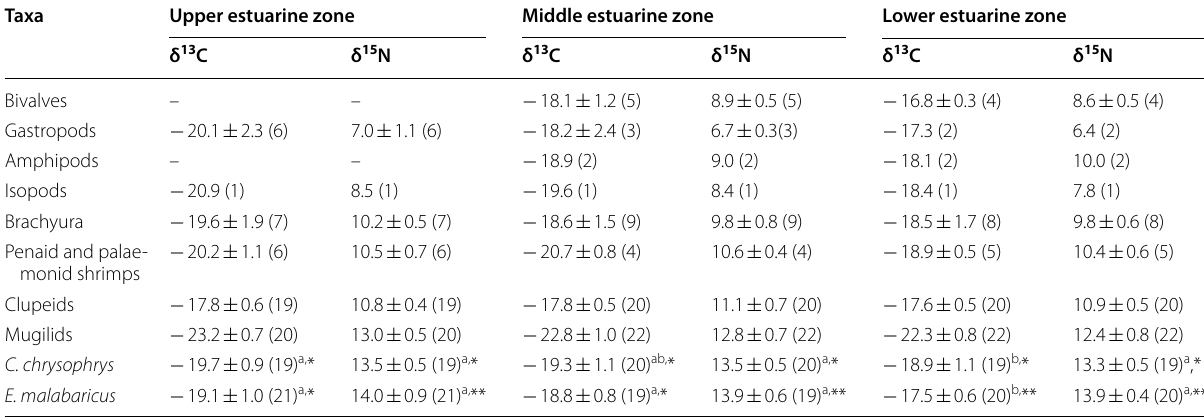
standard deviation) in the Pangani estuary ±